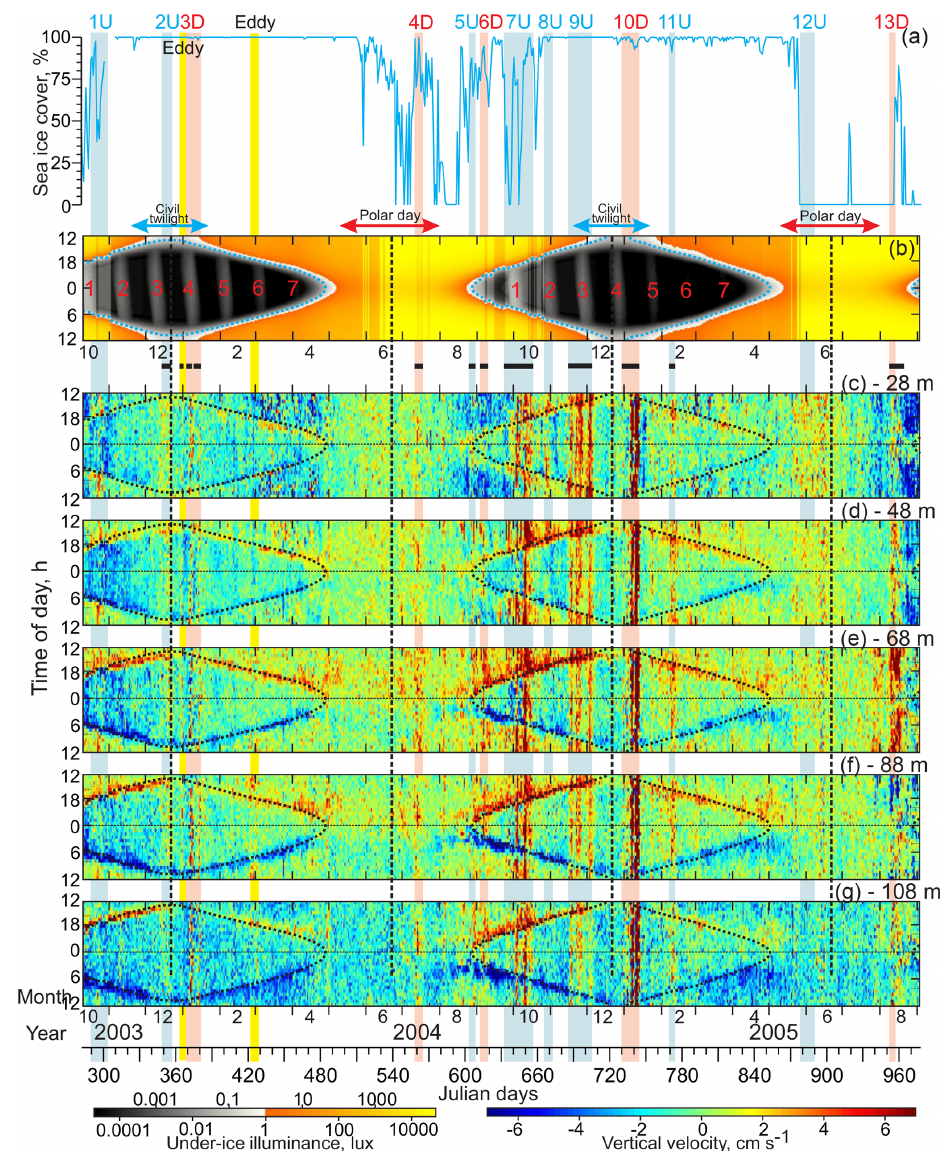
Figure 8. (a) Time series of sea-ice concentrations (%). Actograms of (b) modeled under-ice illuminance (lux) based on HYCOM + CICE sea-ice thickness and (c–g) ADCP-measured vertical velocity (cms − 1 ) at five depth levels: (c) 28, (d) 48, (e) 68, (f) 88, and (g) 108m. Positive–negative values correspond to the upward–downward flow. Horizontal black lines at the top of panel (c) depict periods of noise in vertical velocity attributed to spatial inhomogeneity of the flow field and errors in the ADCP tilt angle (for more details, see Sect. 3). All other designations are similar to those in Fig.